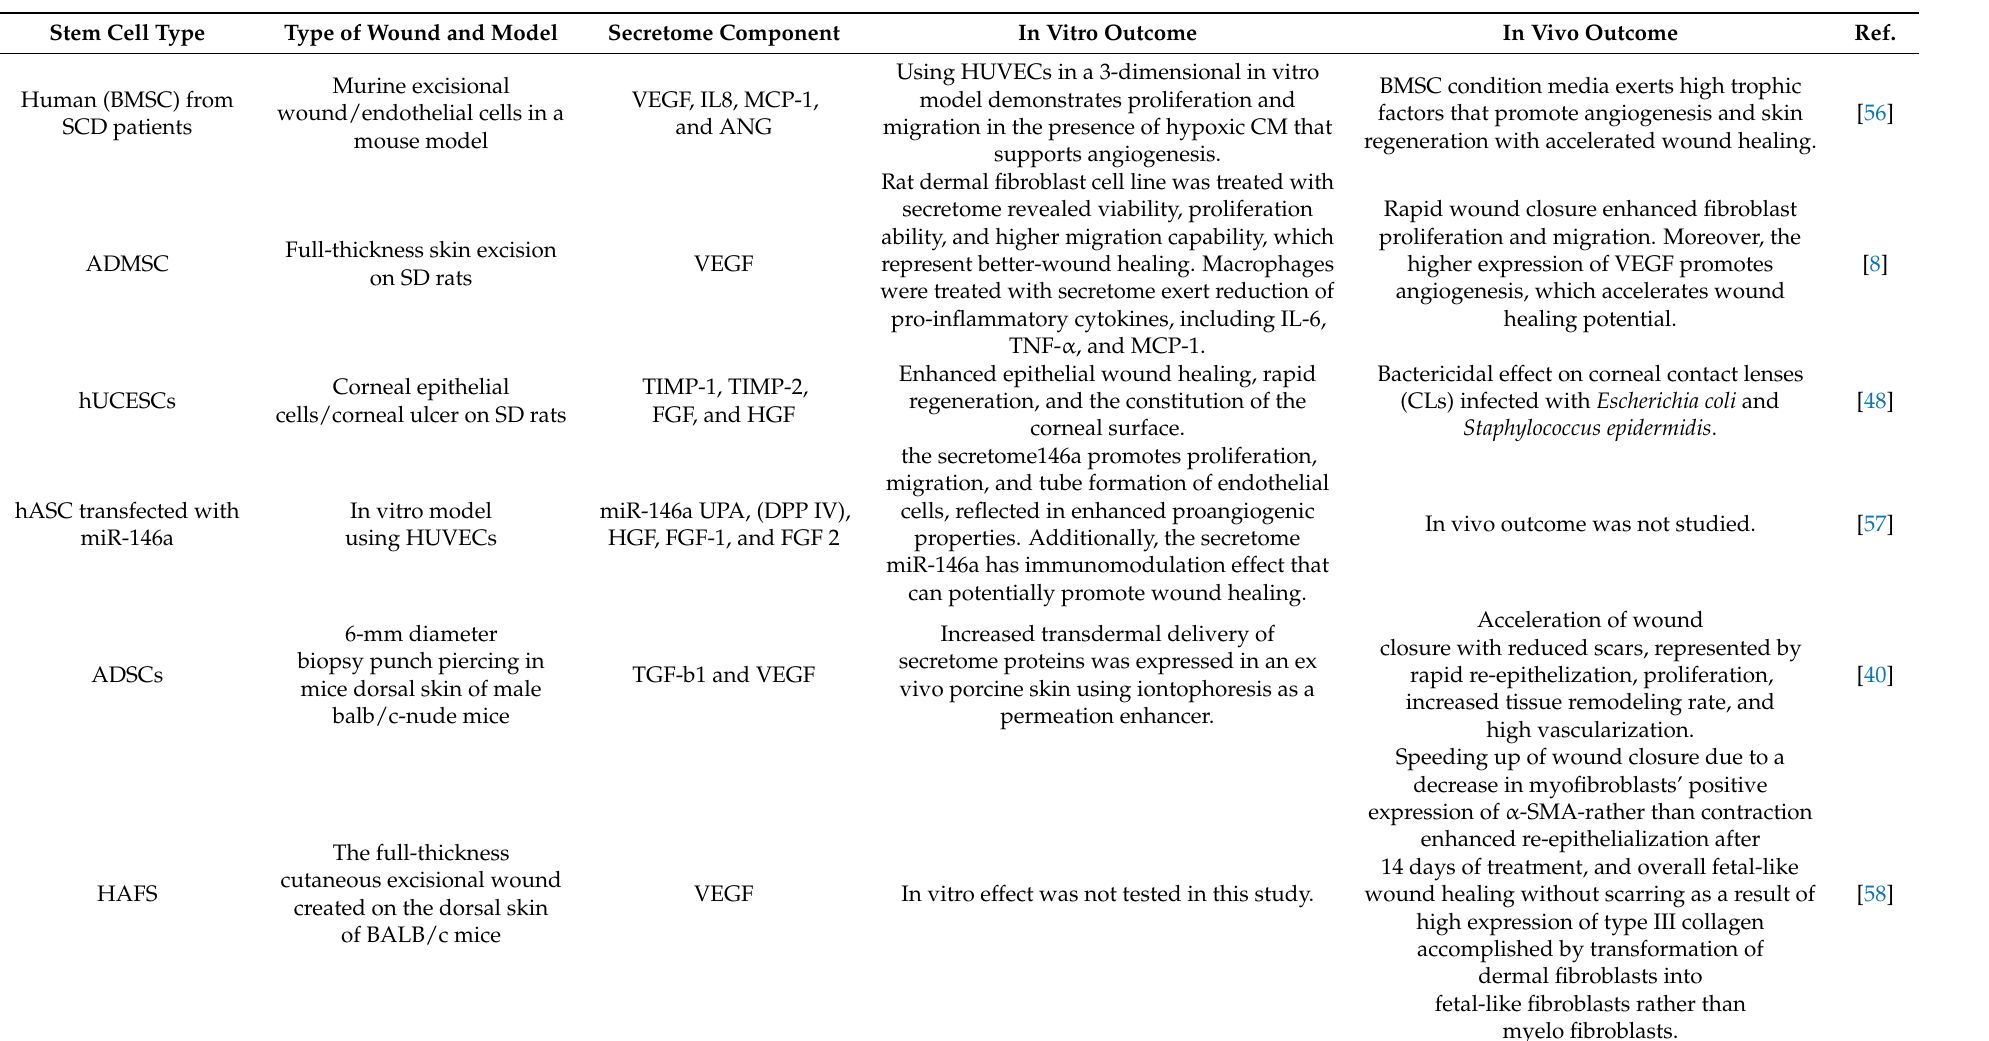
Table 1. The therapeutic outcomes of MSC secretome (MSC-S) in wound